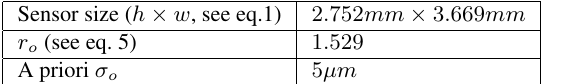
Table 3: Fixed interior parameters for all cameras.